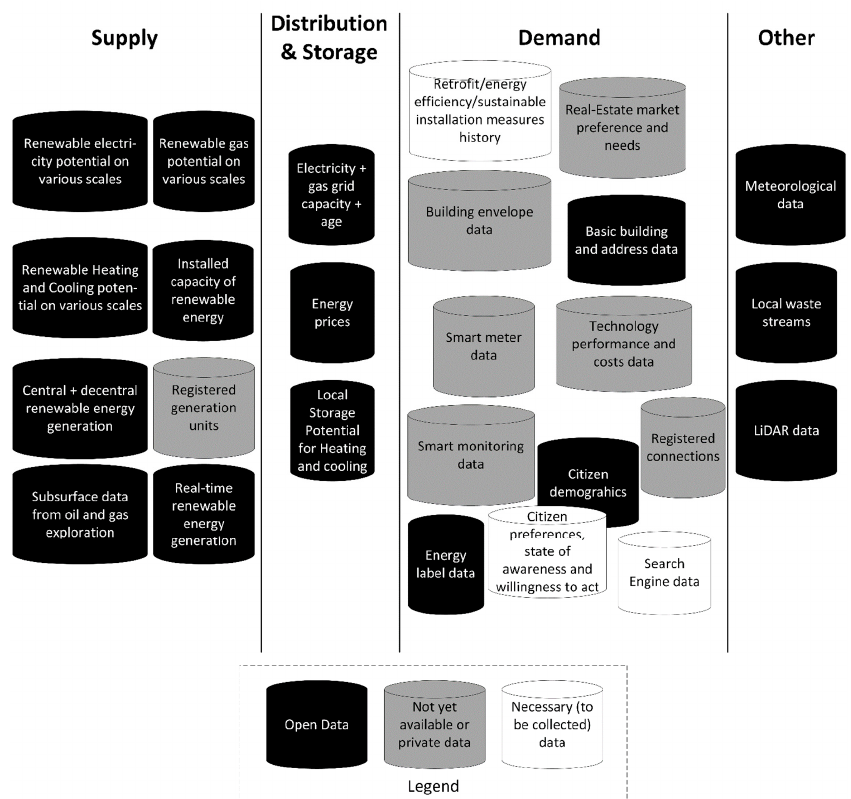
Figure A1. Overview of data sources (current and potential) with relevance for the heat transition. Energies 2020 , 13 , x FOR PEER REVIEW